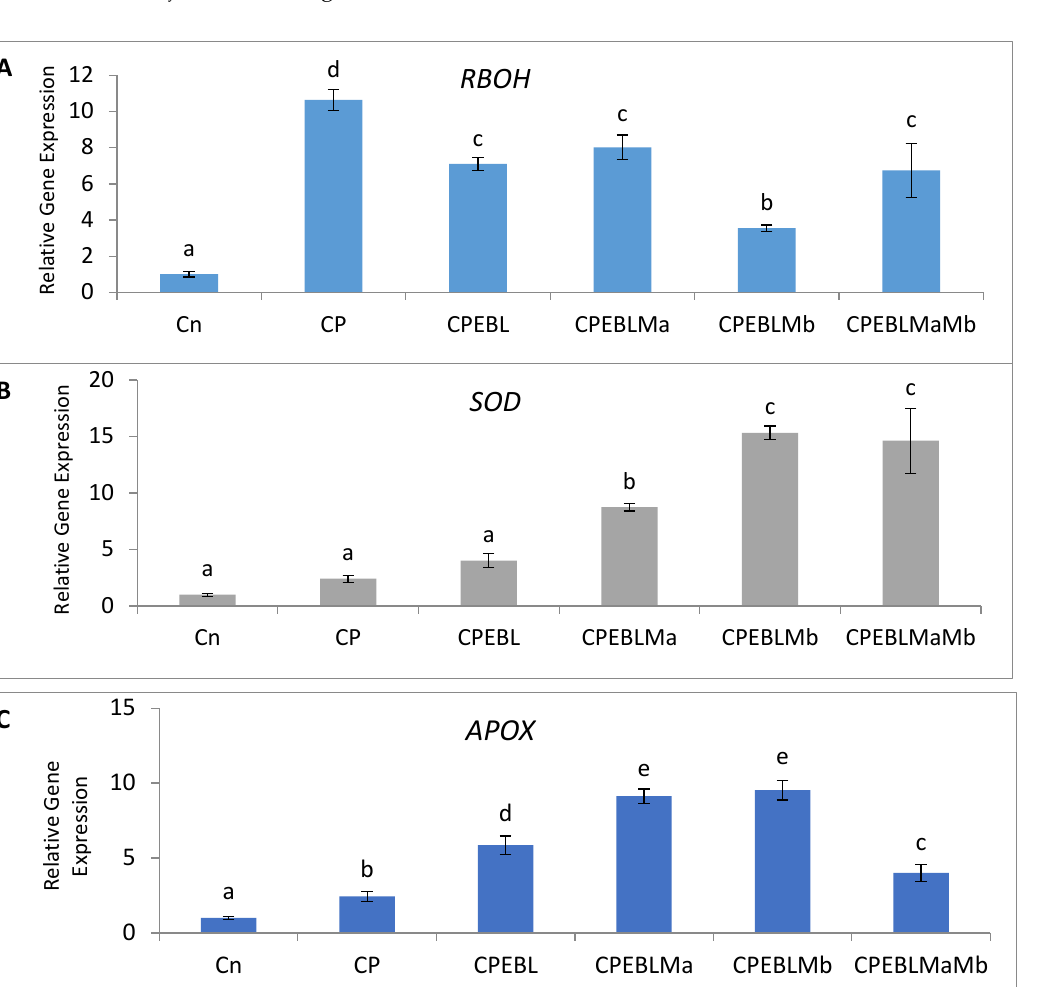
Figure 6. Effect of seed priming with 100 nM of 24-epibrassinolide (EBL) and plant-growth-promoting rhizobacteria ( Pseu- domonas aeruginosa (Ma, 10 9 cells/mL) and Burkholderia gladioli (Mb, 10 9 cells/mL)) on gene expression of ( A ) RBOH, ( B ) SOD, ( C ) APOX, ( D ) DHAR, E) GR and ( F ) CAT of 10-day-old B. juncea L. seedlings under chlorpyrifos (CP) toxicity. Data are presented as mean of three replicates ± s.d. (standard deviation). Means were compared using two-way analysis of variance followed by Tukey’s post -hoc test ( p < 0.05). Different superscripts indicate significant difference between the treatments.